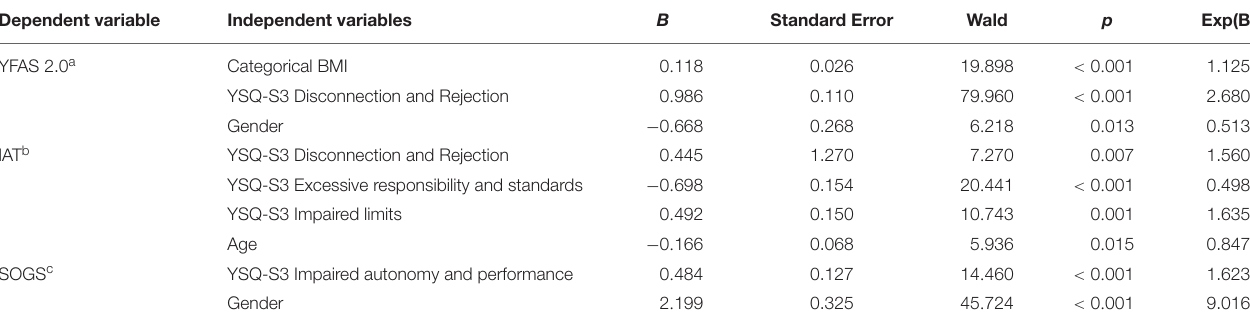
TABLE 4 | Results of logistic regression